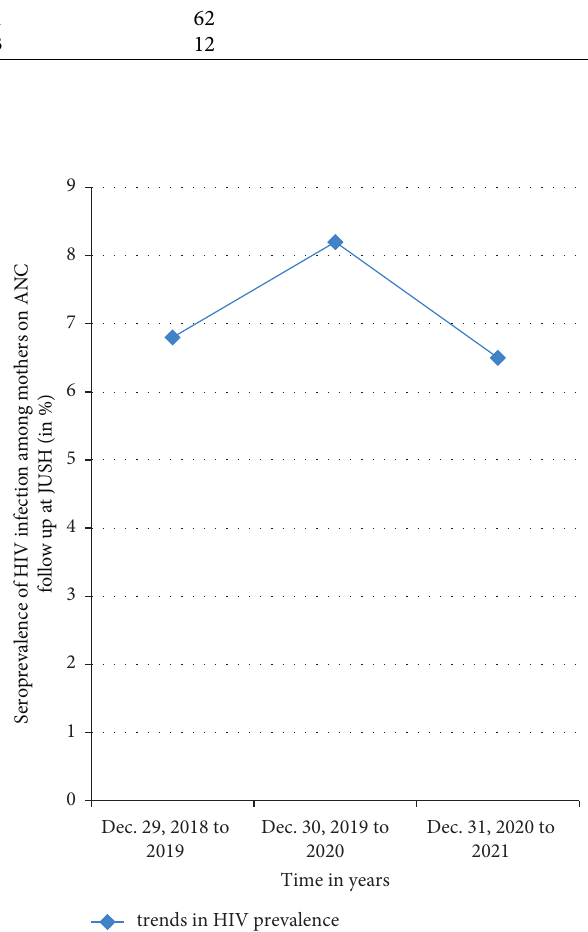
Figure 4: Trend of HIV seropositivity over the consecutive three years among pregnant mothers on ANC follow-up at JUSH.